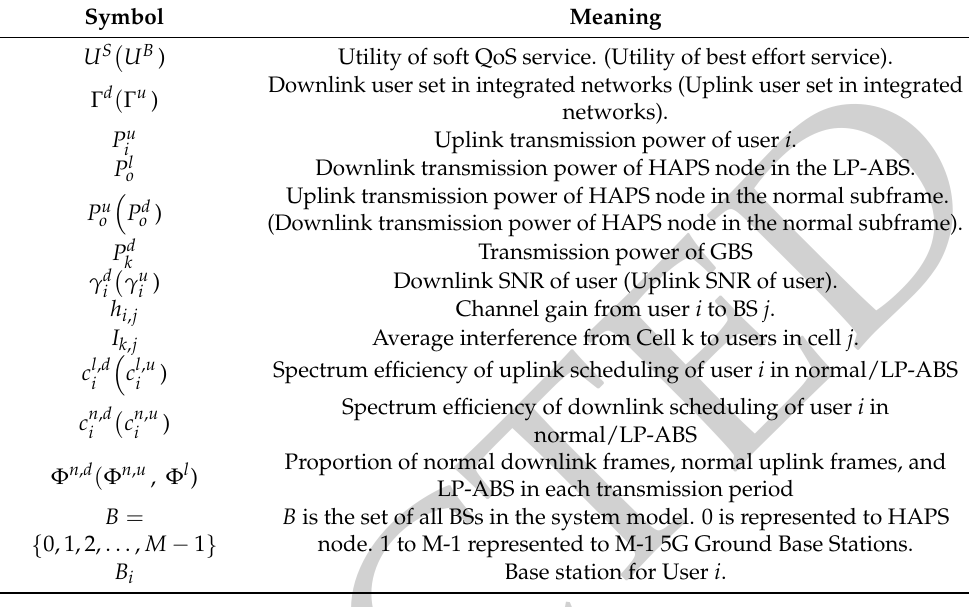
Table 1. Parameter symbols and physical